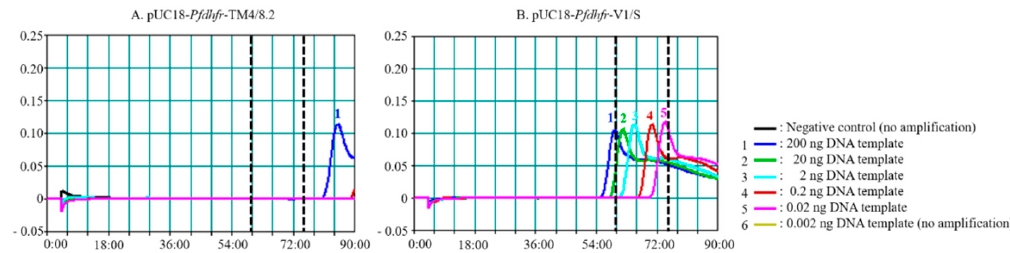
Figure 2. Detection limit of Pf SNP-LAMP reaction using Bst 2.0 WarmStart DNA polymerase. The amplification reactions were performed at 63 °C using 10-fold serial dilutions (0.002 to 200 ng) of ( A ) pUC18- Pfdhfr -TM4/8.2 and ( B ) pUC18- Pfdhfr -V1/S. Similar experiments were performed independently in five replications.